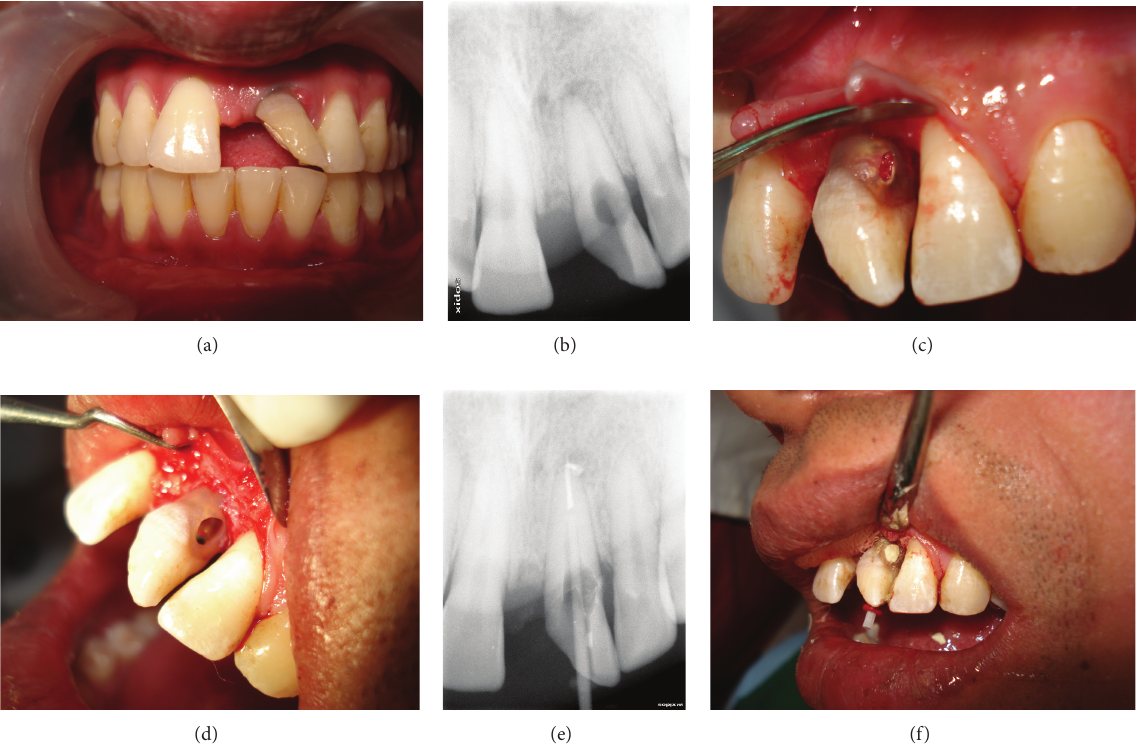
Figure 1: (a) Clinical photograph of case with fractured upper left central showing discolouration at the cervical area and sinus tract at distobuccal aspect. (b) Radiograph showing circular resorptive cavity which extends on the external aspect of distal buccal area. (c) Surgical site represents circular Resorptive site housed with the granulomatous tissue. (d) Clinical photograph showing the removal of granulomatous tissue. (e) Radiograph shows the sectional obturation and placement of fibre post. (f) Resorptive site filled with white